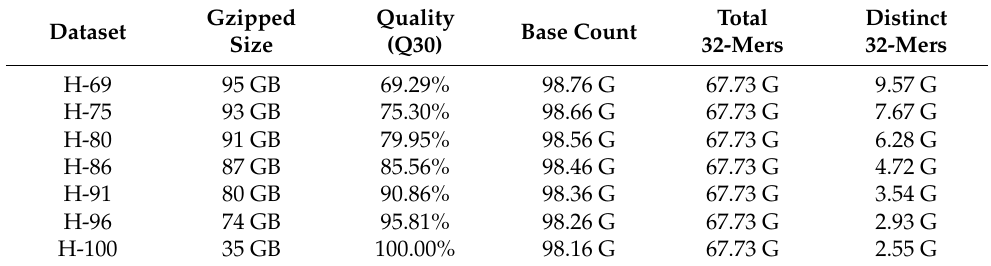
Table 2. Simulated datasets with various sequencing quality ( H. sapiens , 30X).